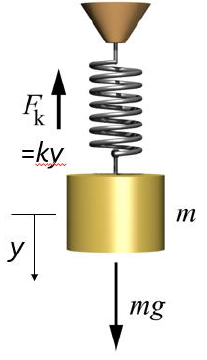
Fig. 16. Spring-mass system